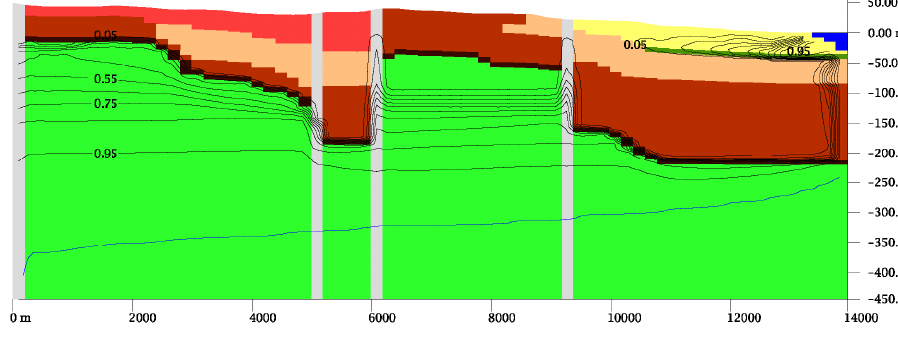
Figure 10: a) surveys concerning the shallow aquifer:  1) Surveys carried out in 2007 with TDS > 450 mg/l; 2) Surveys carried out in 2007 with TDS < 450 mg/l; 3) Surveys carried out in 2006 with TDS > 450 mg/l; 4) Surveys carried out in 2006 with TDS < 450 mg/l. b) 5)Surveys concerning the deep aquifer. Interpolated depths of b) seawater (35 g/l) and c) interface (5 g/l).